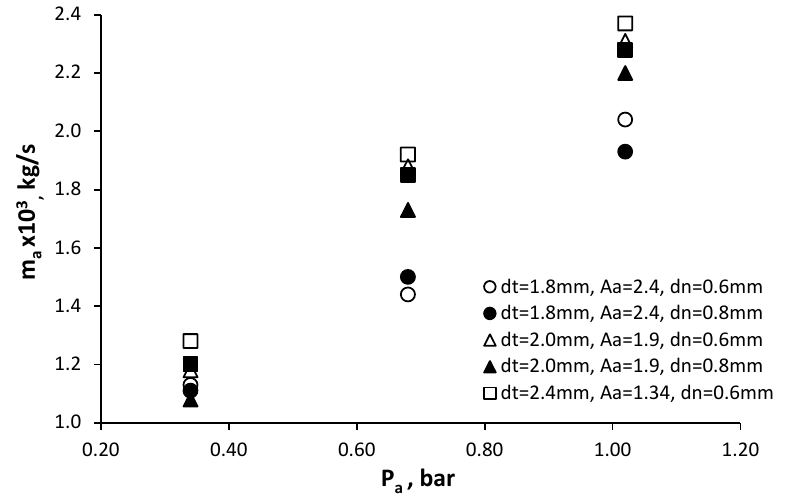
Figure 11. Air flow rate characteristics of the swirl chamber.